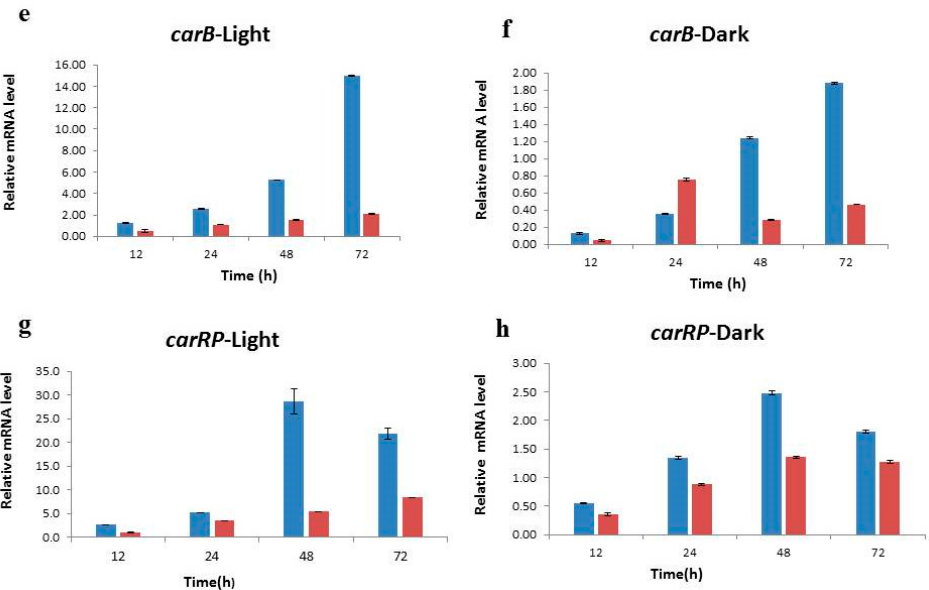
Figure 5. Determination of expression levels of four key genes involved in β -carotene synthesis pathway in CBS277.49 and WJ1. ( a ) hmgS -light), ( b ) hmgS -dark, ( c ) carG -light, ( d ) carG -dark, ( e ) carB -light, ( f ) carG -dark, ( g ) carRP -light, and ( h ) carRP -dark.